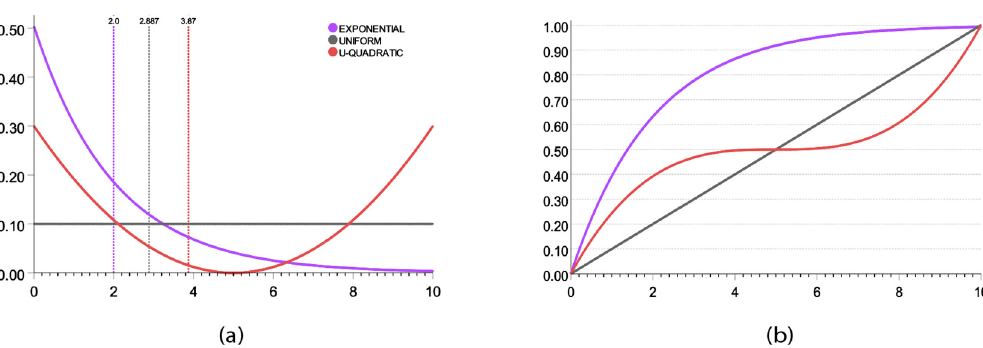
Figure 1. Probability density functions (PDF) and one standard deviation distances from origin for three hypothetical models of impairment distribution ( a ) and their corresponding cumulative distribution functions (CDF) ( b ). The three distributions follow Exponential (purple), Uniform (grey), and U-Quadratic (red) functions. The abscissa represents amount of impairment. The ordinate quantifies probability ( a ) or cumulative probability ( b ).